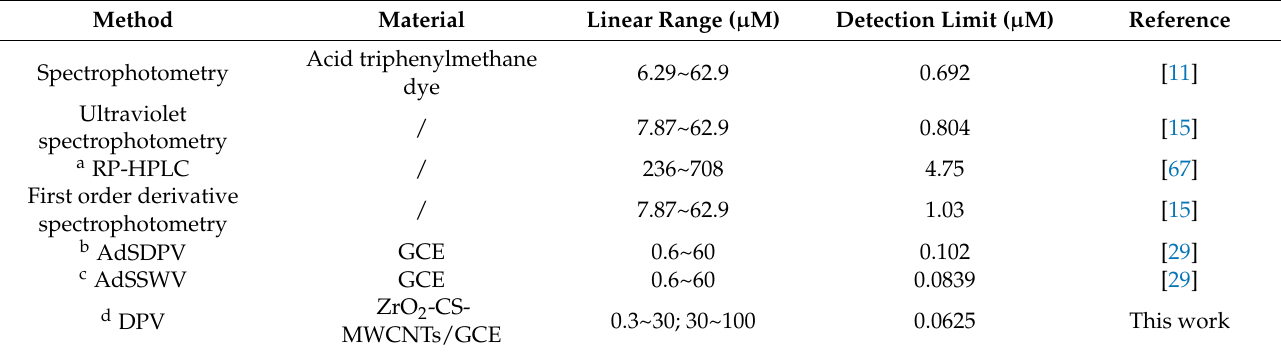
Table 1. Comparison of various Tenofovir disoproxil fumarate (TDF) determination